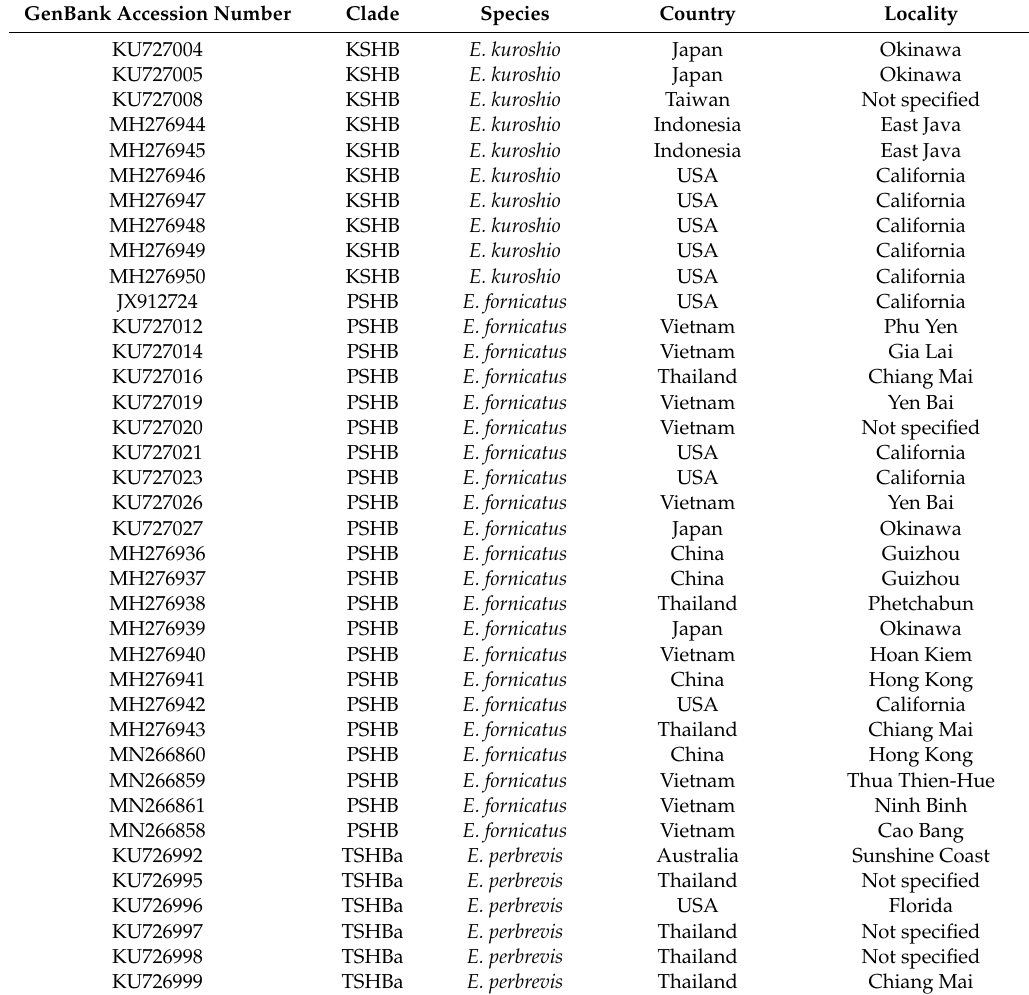
Table 1. GenBank accession numbers for the 70 COI sequences used in this study, and the associated clade name, species, and locality